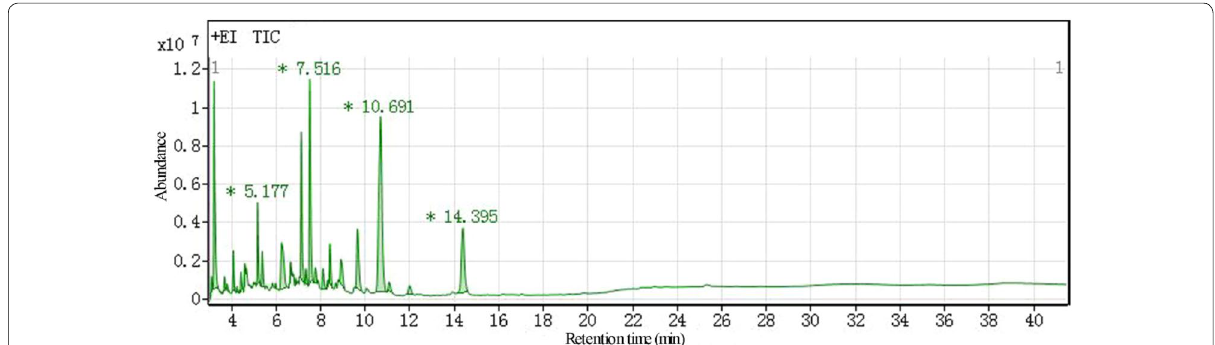
Fig. 3 The total ion chromatograms of the effluent from 185 ℃ /1 h heat treatment